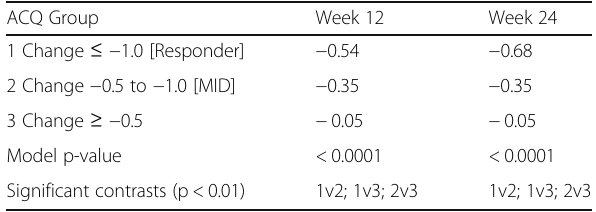
Table 4 Changes in Average 7-Day ASD Score by ACQ Change Groups at Weeks 12 and